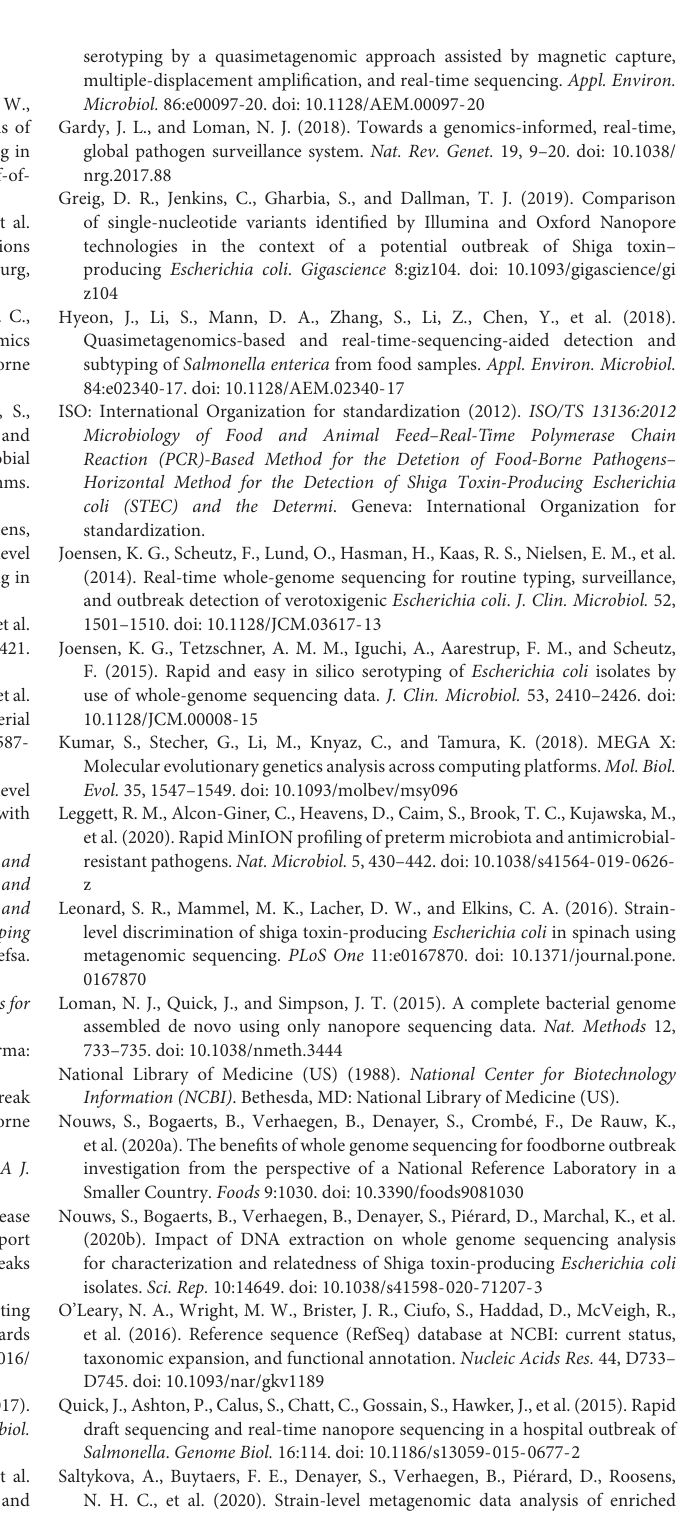
Supplementary Material 2 | Workflow of command lines for bioinformatics analyses used in this study. Supplementary Material 3 | Reference coverage and total and relative SNP distances (per million genomic positions) of the STEC phylogenetic tree.